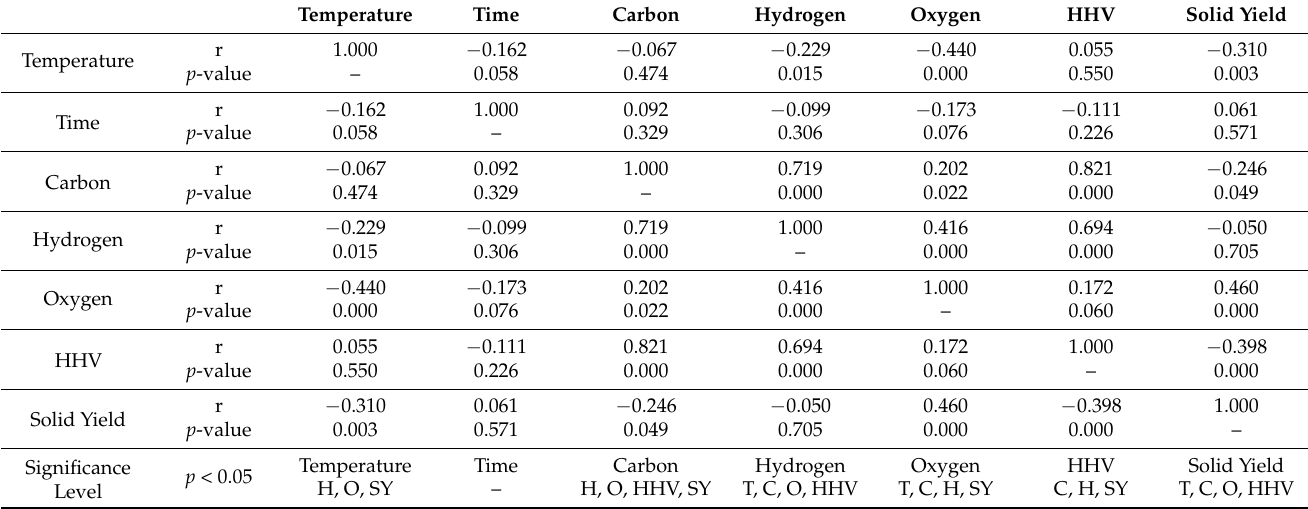
Table 1. Hydrochar properties’ Pearson correlation matrix (CI =